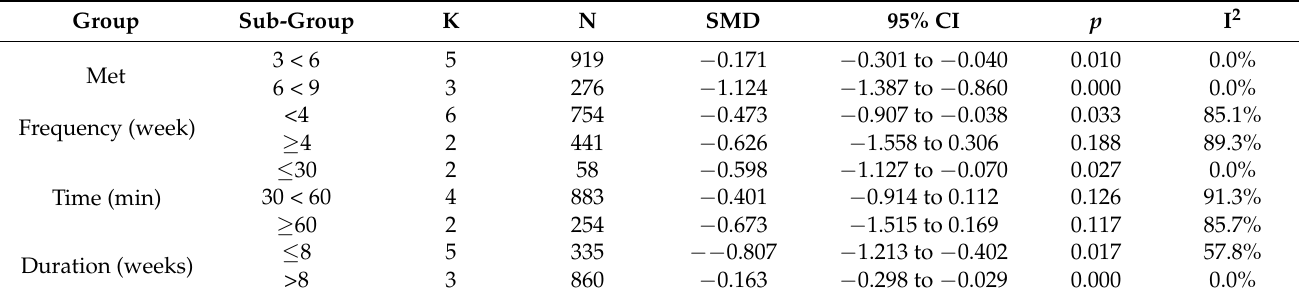
Table 6. Subgroup analysis of physical activity on anxiety disorder of university students.